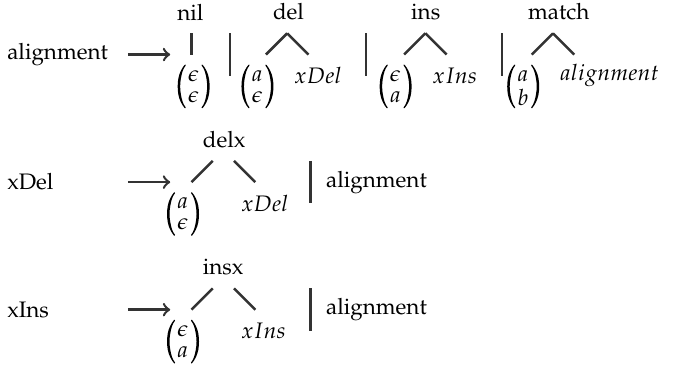
Figure 1. Tree grammar for the Gotoh algorithm for the Belmann’s GAP compiler. Symbol (cid:101) stands for an empty character; a and b stand for any character in the sequence alphabet.